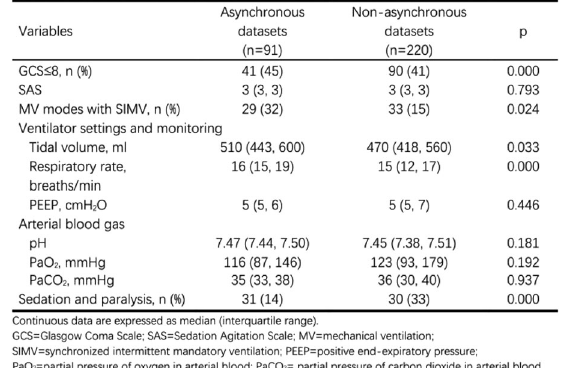
Table 1 (abstract 000314). Variables in asynchronous and non- asynchronous datasets